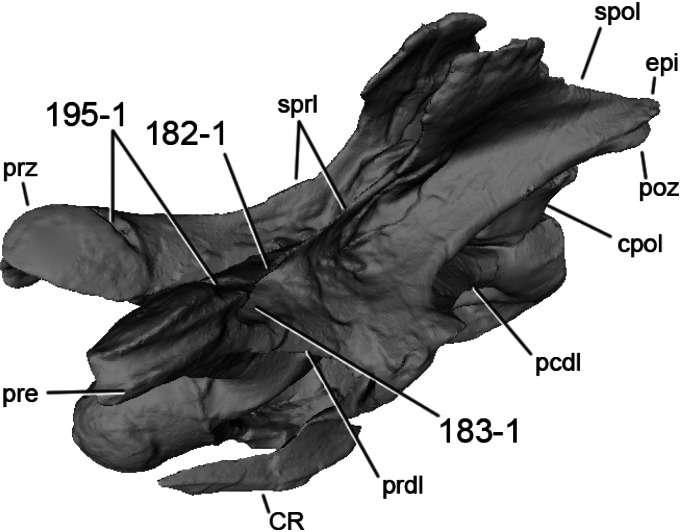
Cervical vertebra 12 of Kaatedocus siberi SMA 0004 in lateral anterodorsal view.Note the laterally tilted anterior portion of the sprl (C182-1), the lateral fossa marking the anterior end of the spinodiapophyseal fossa (C183-1), and the transverse sulcus accompanying the prezygapophyseal facet posteriorly (C195-1). Abb.: cpol, centropostzygapophyseal lamina; CR, cervical rib; epi, epipophysis; poz, postzygapophysis; prdl, prezygodiapophyseal lamina; pre, pre-epipophysis; prz, prezygapophysis; spol, spinopostzygapophyseal lamina; sprl, spinoprezygapophyseal lamina. 3D digital model provided by G Dzemski.